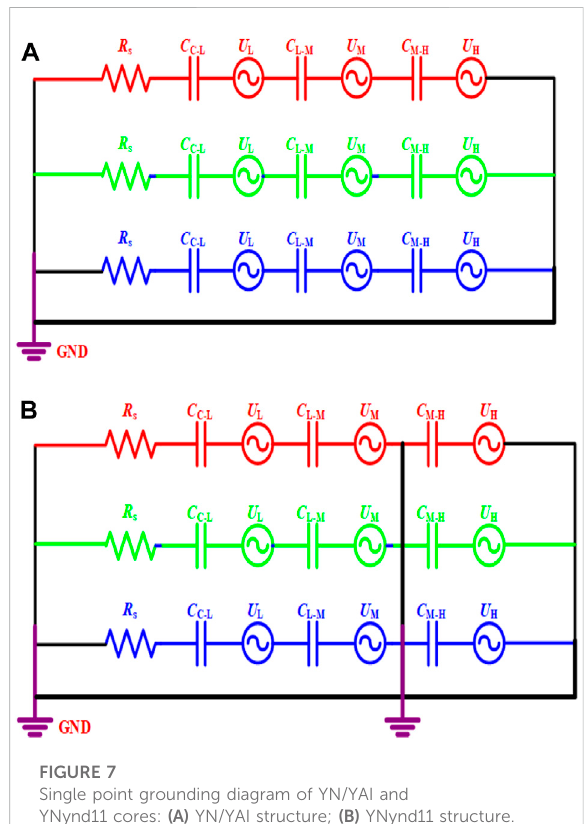
FIGURE 7 Single point grounding diagram of YN/YAI and